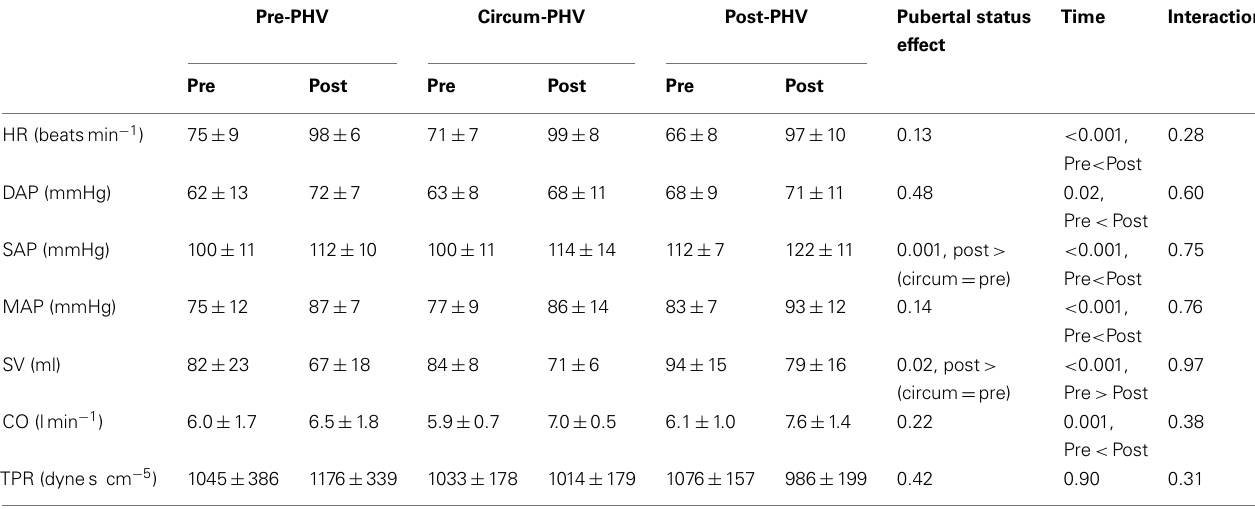
Table 3 | Resting hemodynamic measures both before and after maximal incremental exercise in highly trained young soccer players grouped according to maturity